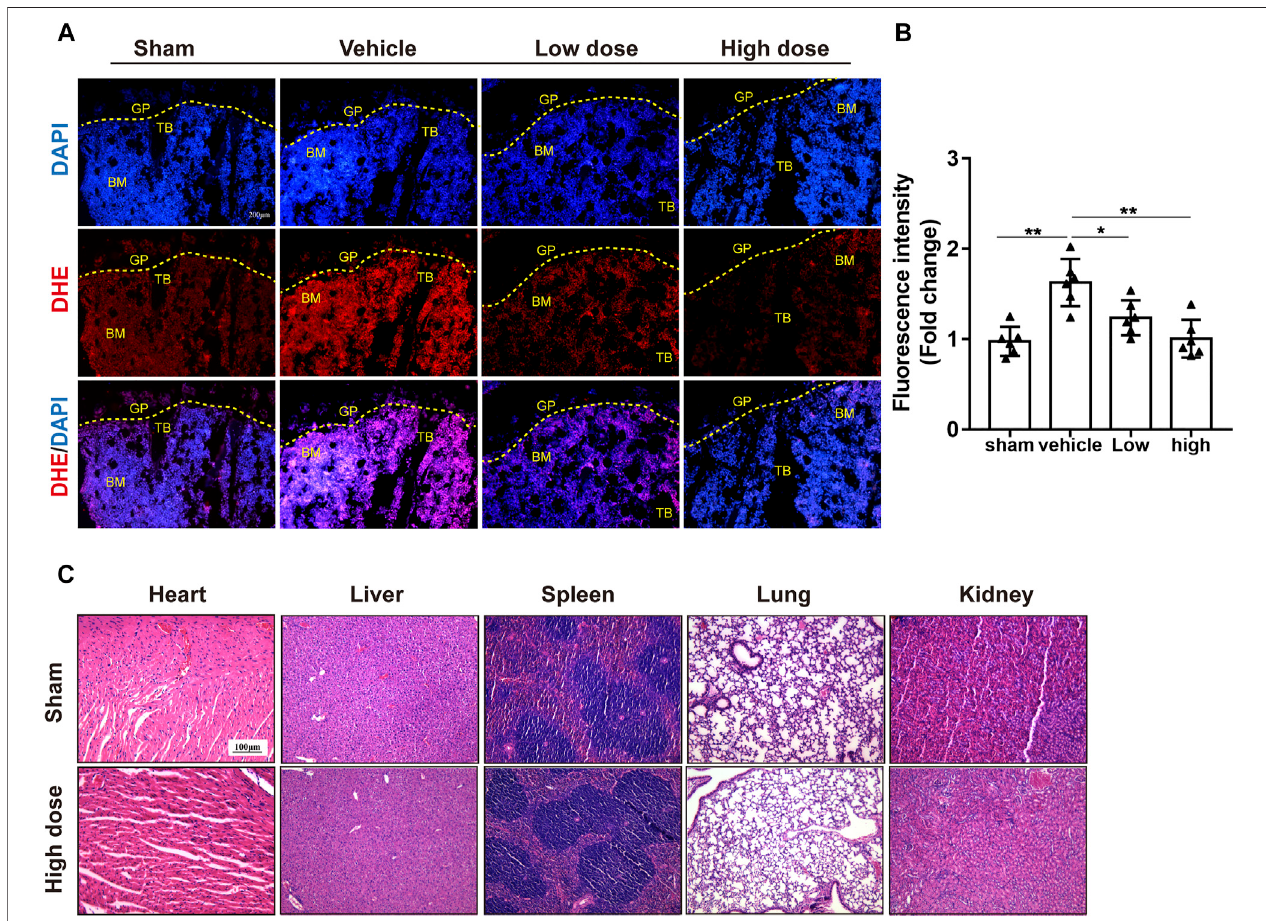
FIGURE 7 | Azilsartan reduced ROS production in OVX mice. (A) Representative images ofbone cryosections showing ROS production in each group using DHE fl uorescence staining. (B) Quantitative analysisofROS fl uorescence (Red)intensity( n (cid:2) 6per group). (C) H&E stainingofthe heart, liver, spleen,lung, and kidney tissues of mice in the Azilsartan-treated and control groups. All data were shown as mean ± SD. (* p < 0.05, ** p < 0.01, *** p < 0.005, compared with the vehicle group). TB, trabecular bone; GP, growth plate; BM, bone marrow; DHE,